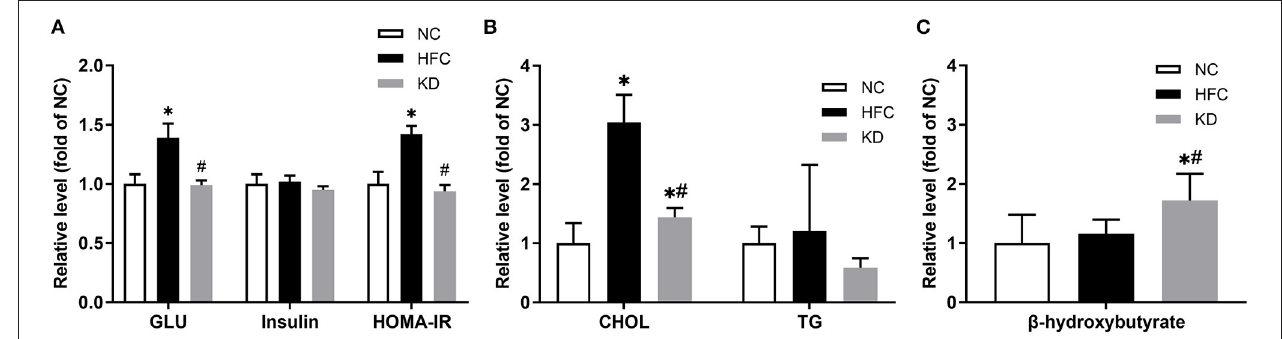
FIGURE 1 | Effects of a high-fat and high-cholesterol diet and a ketogenic diet on (A) serum glucose (GLU), insulin and HOMA-IR, (B) serum total cholesterol (CHOL) and triglycerides (TG), and (C) serum β -hydroxybutyrate level in male mice. Data are expressed as the mean ± SD. * p < 0.05, compared with the NC group; # p < 0.05, compared with the HFC group. NC, normal diet; HFC, high-fat and high-cholesterol diet; KD, HFC diet changed to MCT-based ketogenic diet.